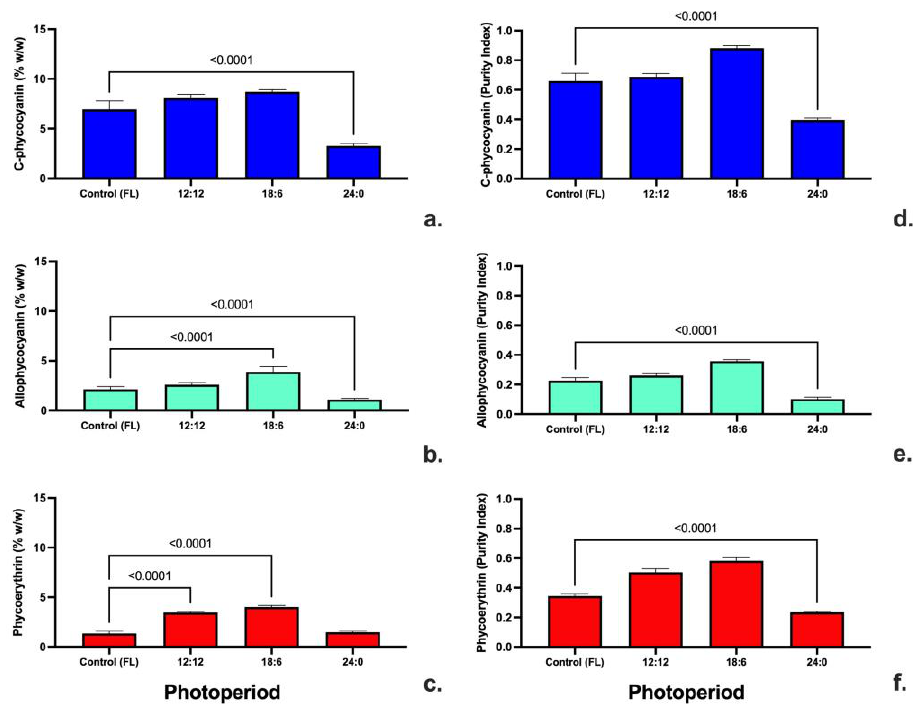
Figure 7. The concentration of phycocyanin (C-PC) ( a ), allophycocyanin (APC) ( b ), and phycoerythrin (PE) ( c ) and their purity ( d – f ) different photoperiods of white/red:blue LEDs.